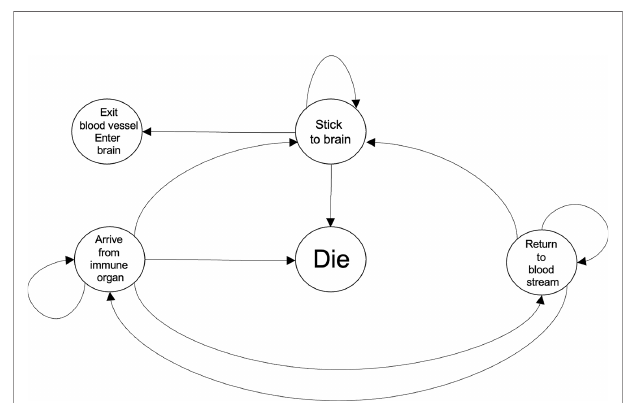
FIGURE 2 | Representative dynamics of the scenarios encountered by an immune cell while coming to the ischemic brain in response to chemokines and DAMPs. The Die and the Exit blood vessel, Enter brain states refer to what would take place at the blood vessels and the brain, respectively. Within a computational framework, the two aforementioned states would be referred to as absorbing states because once an immune cell enters either of those conditions it will not leave that state. Each transition can be associated to a transition probability with the system approximated by a Markov chain. It would be expected that the state transition probabilities will be time-varying and also dependent on a common set of biological variables.